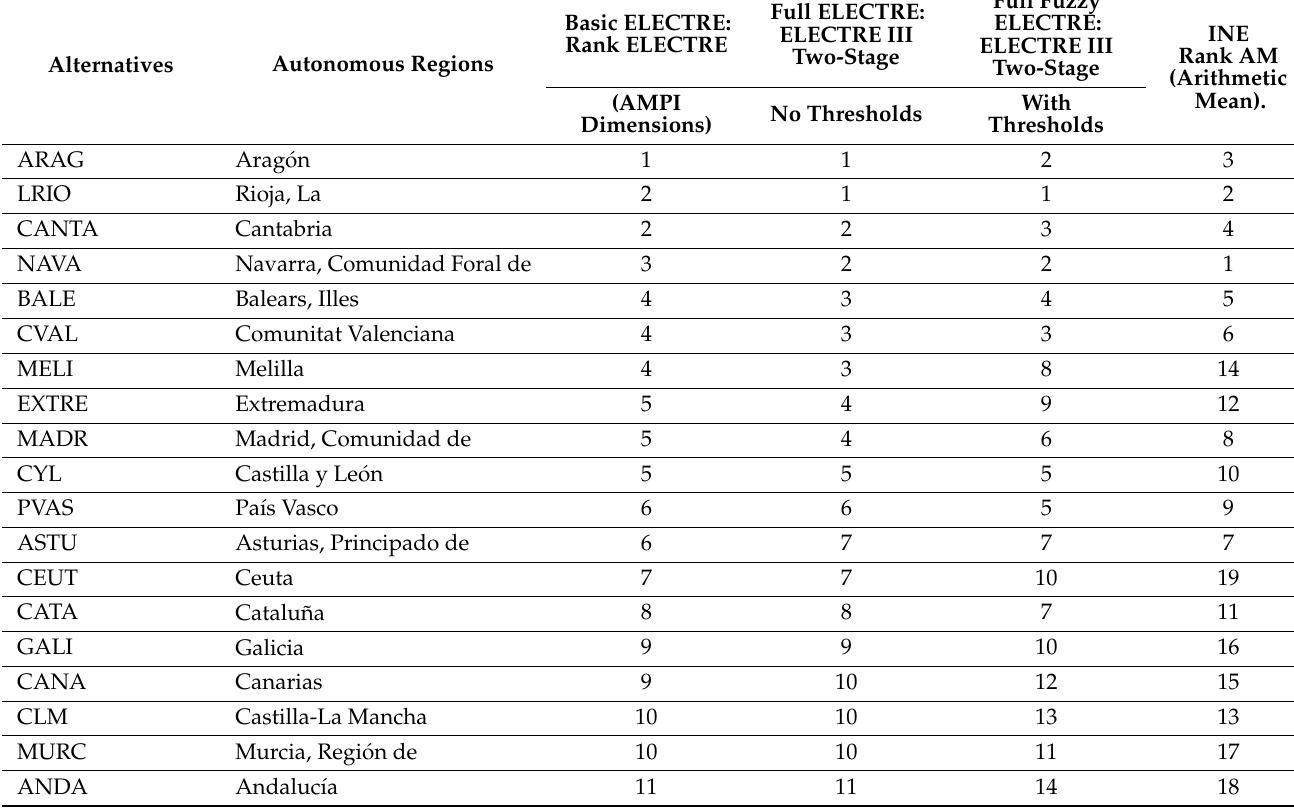
Table 11. Comparison between our results versus INE result using arithmetic